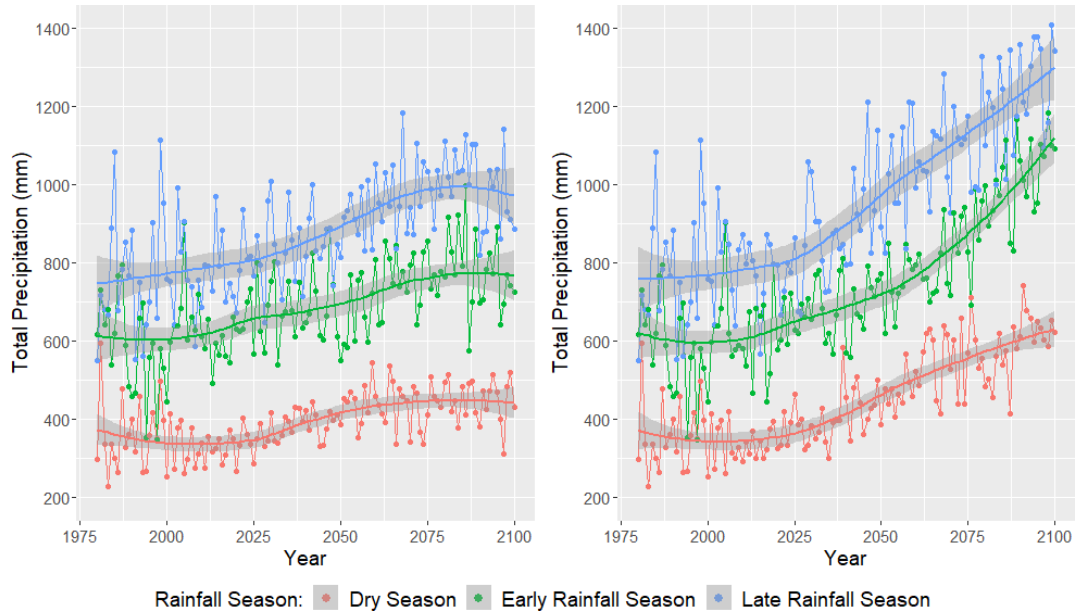
Figure 14. CanESM2 average total precipitation (mm) per weather station by rainfall season for the RCP4.5 forcing scenario (left) and the RCP8.5 forcing scenario (right). The years 1980–2005 represent historical GHCN observations and are also included on these plots. The years 2006–2100 represent downscaled CanESM2 output. This figure was created using Wickham (2016).